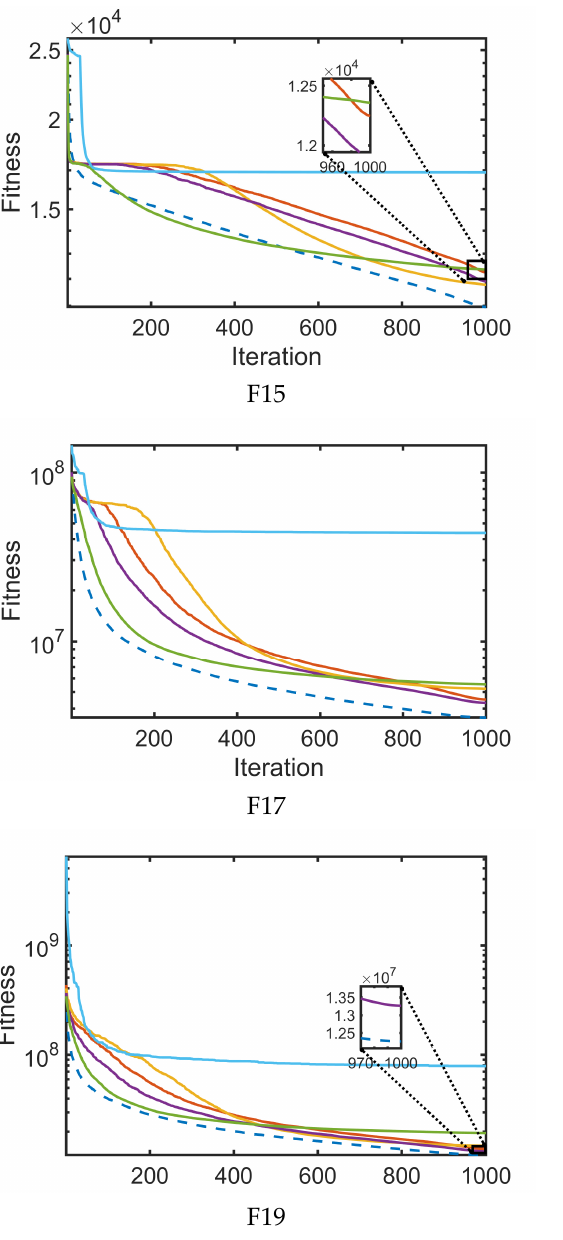
Figure 10. The convergence curves for large-scale functions F1–F20.